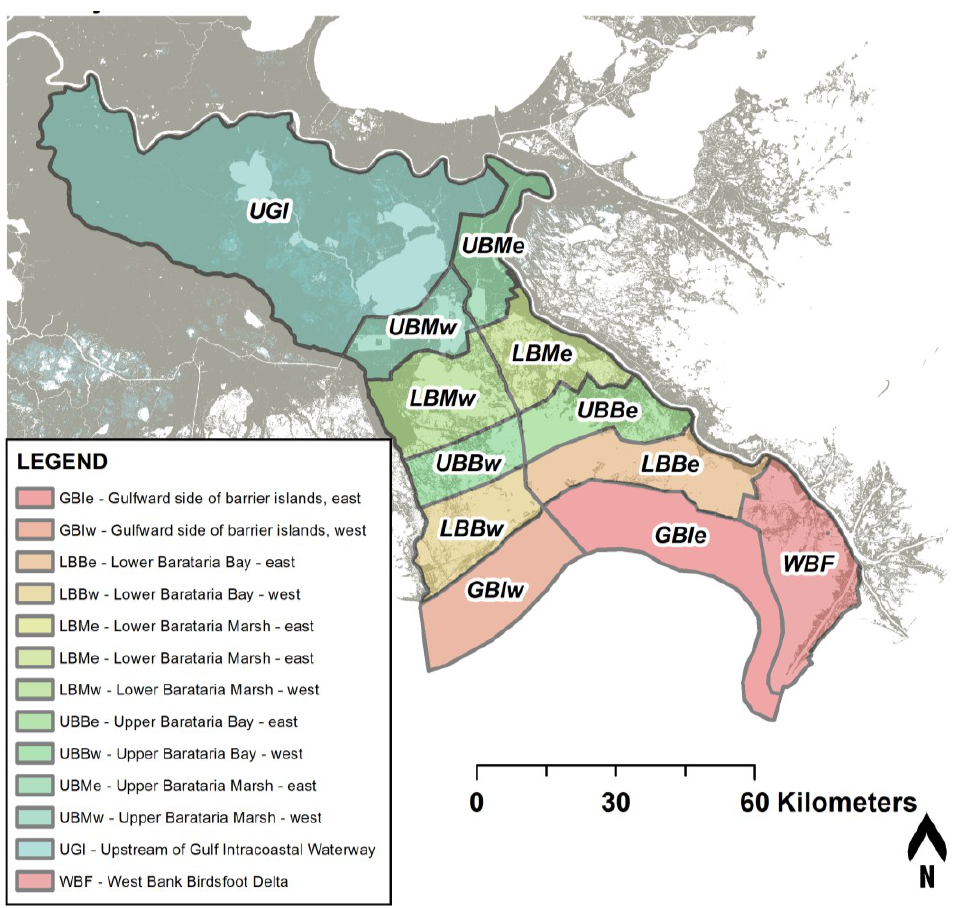
Figure 3. Subdivision of Barataria Basin into 12 zones.